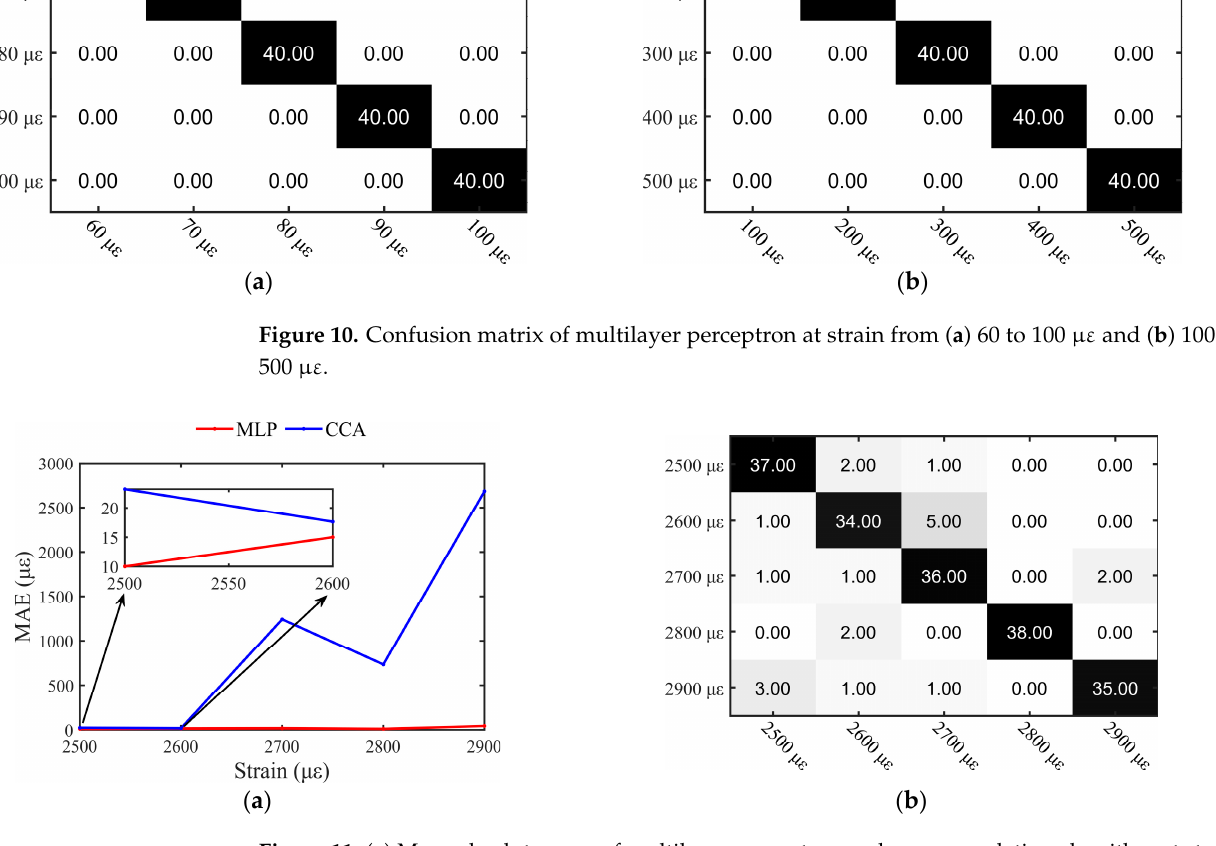
Figure 10. Confusion matrix of multilayer perceptron at strain from ( a ) 60 to 100 µ ε and ( b ) 100 to 500 µ ε .